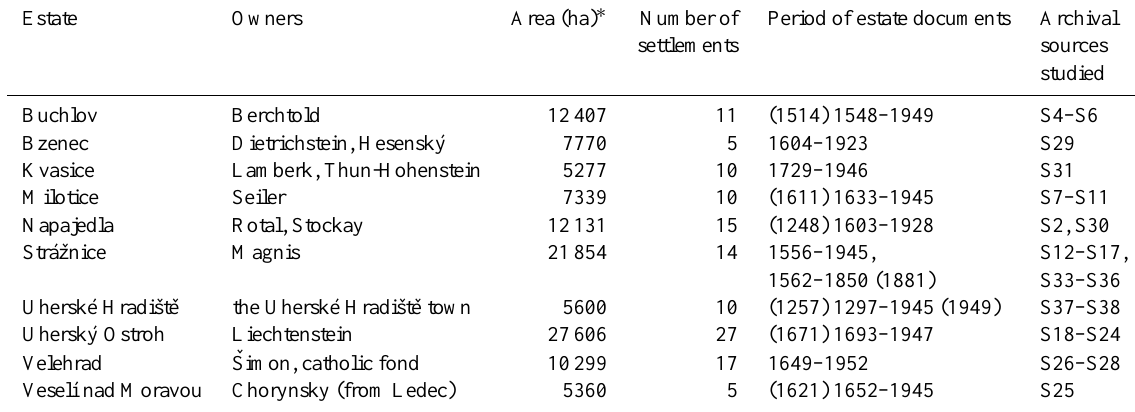
Table 1. Basic facts about the estates in the area studied (the administrative centre of each estate is the same as its name, except for the Buchlov estate, where it was